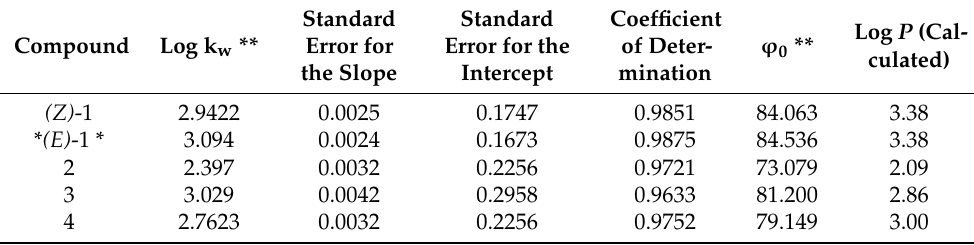
Table 2. Chromatographic partition coefficient (log kw) and hydrophobicity index ( ϕ 0 ) for substrate ( 1 ) and products of its conversion (3-butyl-3-hydroxyphthalide ( 2 ), 3-butyl-3-methoxyphthalide ( 3 ) and 3- n -butylphthalide ( 4 )) along with the calculated partition